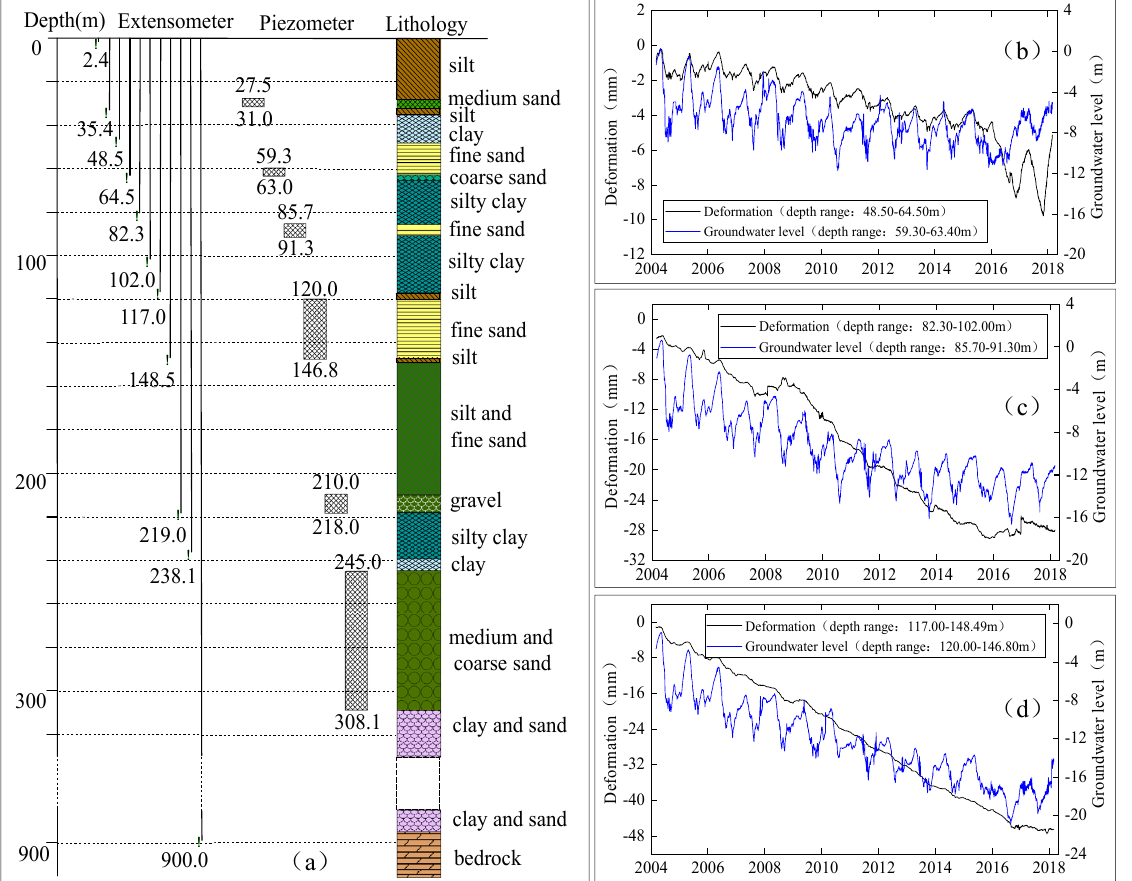
Figure 14. Schematic description of the borehole extensometer and groundwater well at Tianzhu station. The relationship between groundwater and land subsidence. ( a ) Schematic description of the borehole extensometer and groundwater well at Tianzhu. The lithological column is provided together with the depth of deformation. ( b ) The relationship between groundwater and land subsidence at F3-8. ( c ) The relationship between groundwater and land subsidence at F3-6. ( d ) The relationship between groundwater and land subsidence at F3-4.